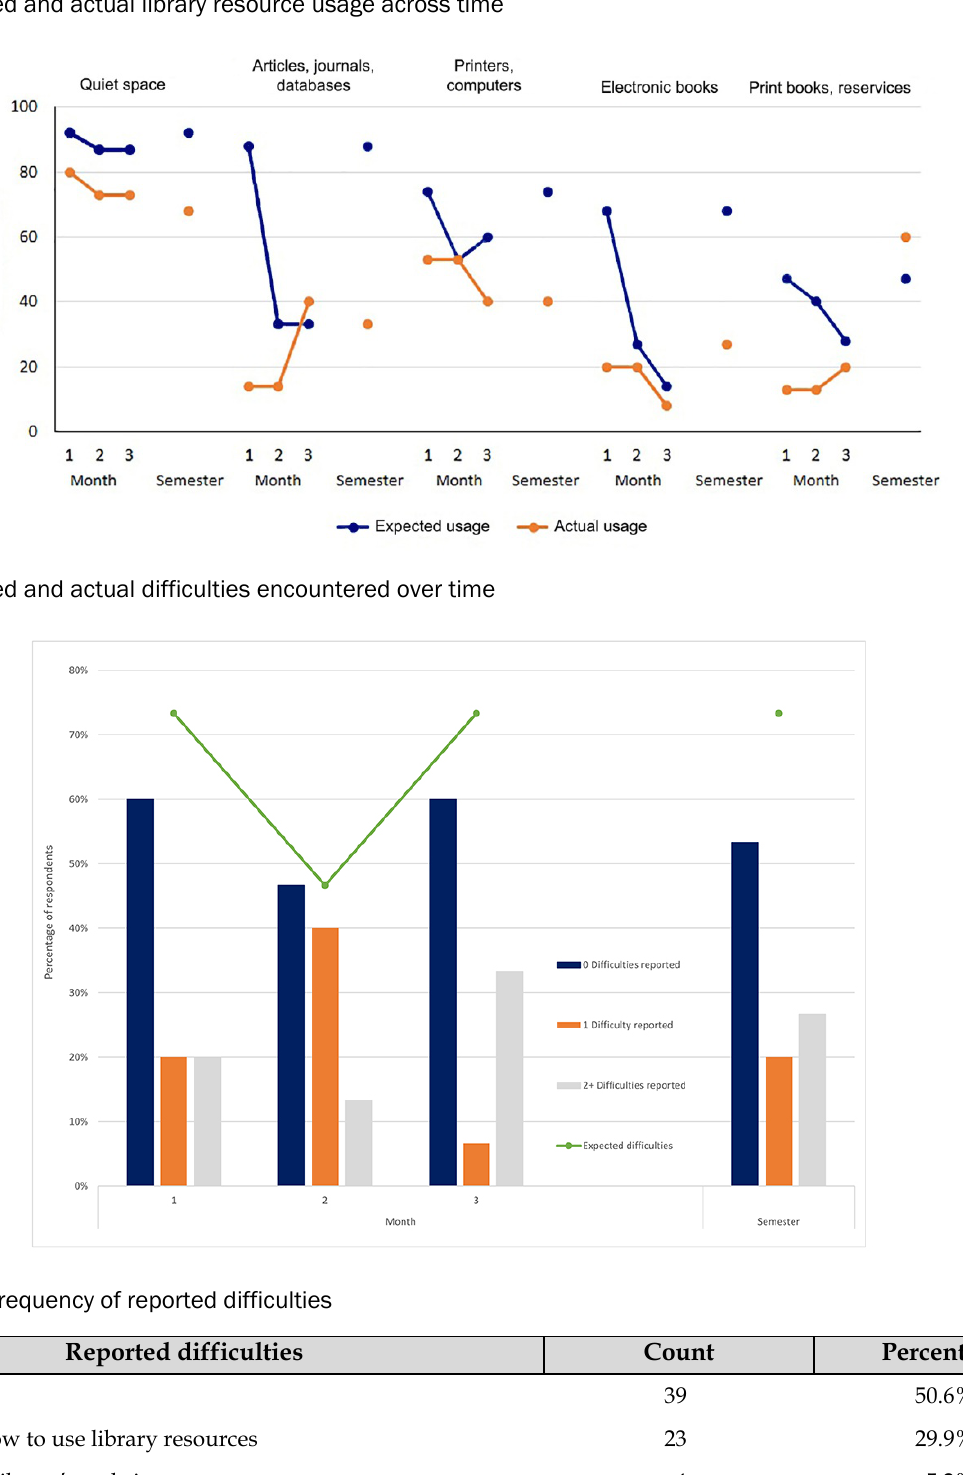
Figure 1 Expected and actual library resource usage across time